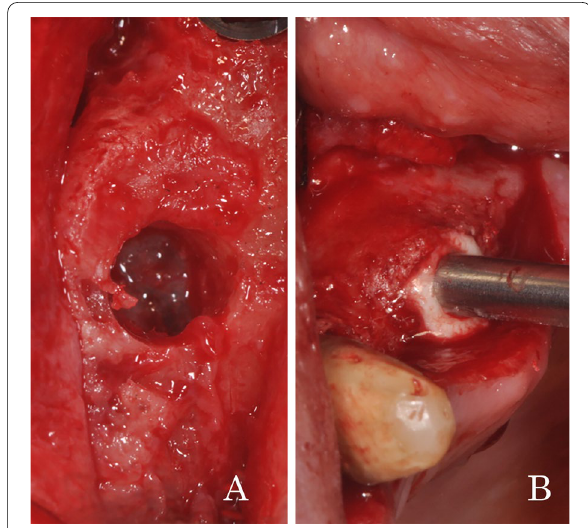
Fig. 3 After performing crestal osteotomy and checking the Schneiderian membrane integrity ( A ), the graft is directly injected into the sub-antral space ( B